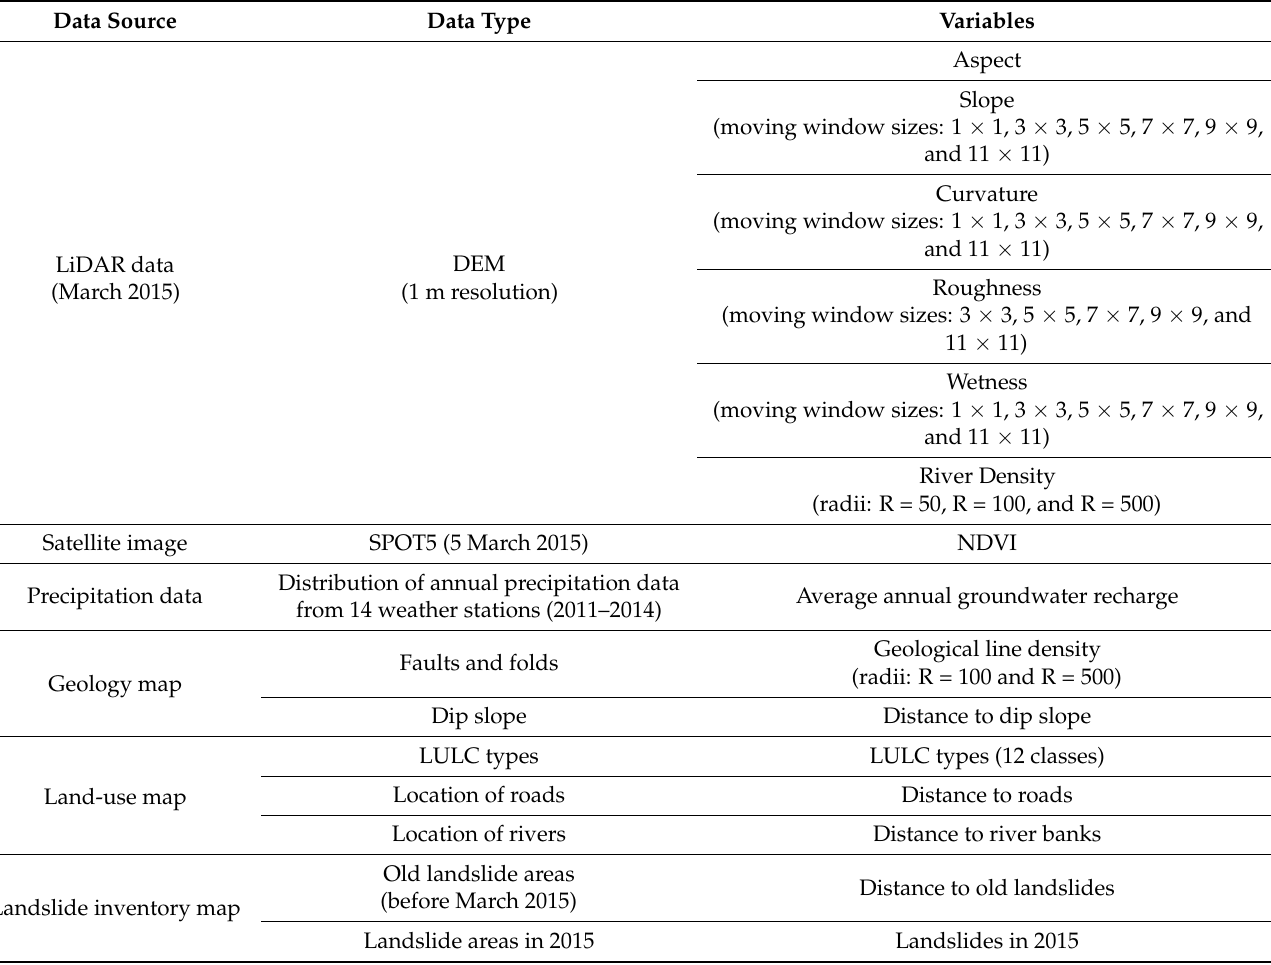
Table 1. Predictive variables derived from various data sources used in this study for landslide